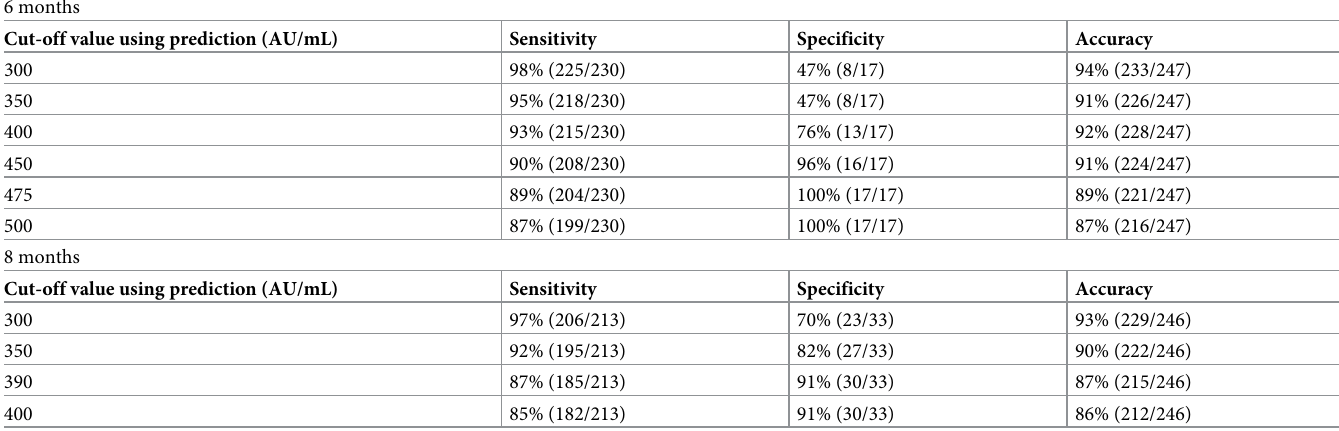
Table 3. Predictive accuracy for spike IgG > 300 AU/mL at 6 months and 8